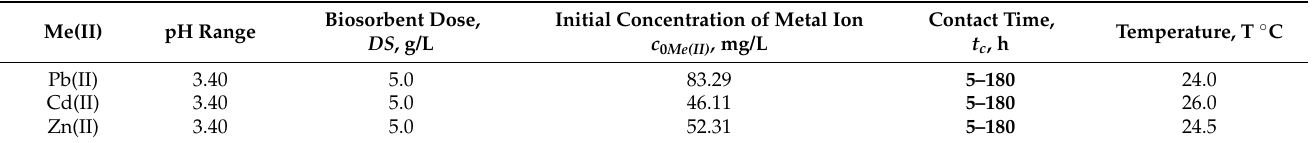
Table 5. The values of the working parameters used in the experimental study of the influence of the contact time on the biosorption process.